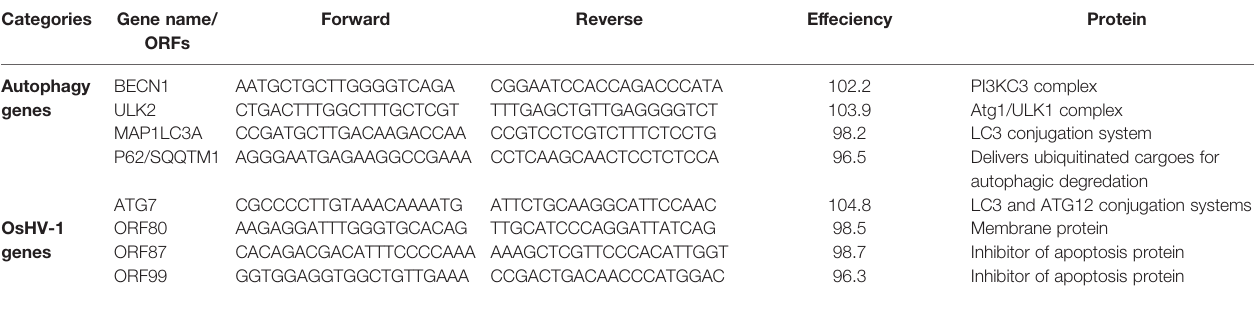
TABLE 1 | List of primer for viral ORF and C. gigas autophagy genes expressions.